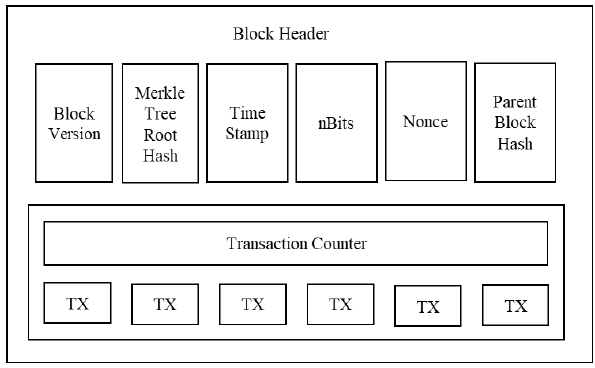
Figure 5. Block structure.